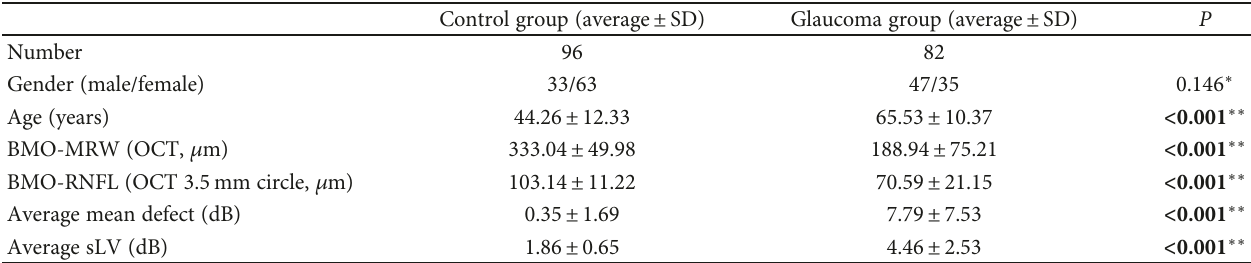
Table 1: Demographic and clinical characteristics of the two groups. Di ff erences with a p value of < 0.05 were considered statistically signi fi cant (in